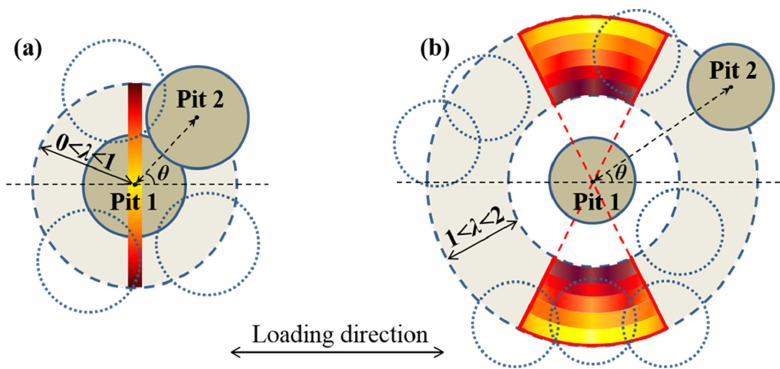
Figure 11. Diagram showing the critical corrosion region for a neighboring pit. The dashed circle represents the possible location for Pit 2, and the colored area corresponds to the critical corrosion region, with the darker color illustrating the higher C-SCF. ( a ) For intersecting pits; and ( b ) for adjacent pits. Notably, for a fixed λ in Figure 11b, the C-SCF slightly varies with the inclination angle θ , which is schematically illustrated with the color gradients in each stained band.